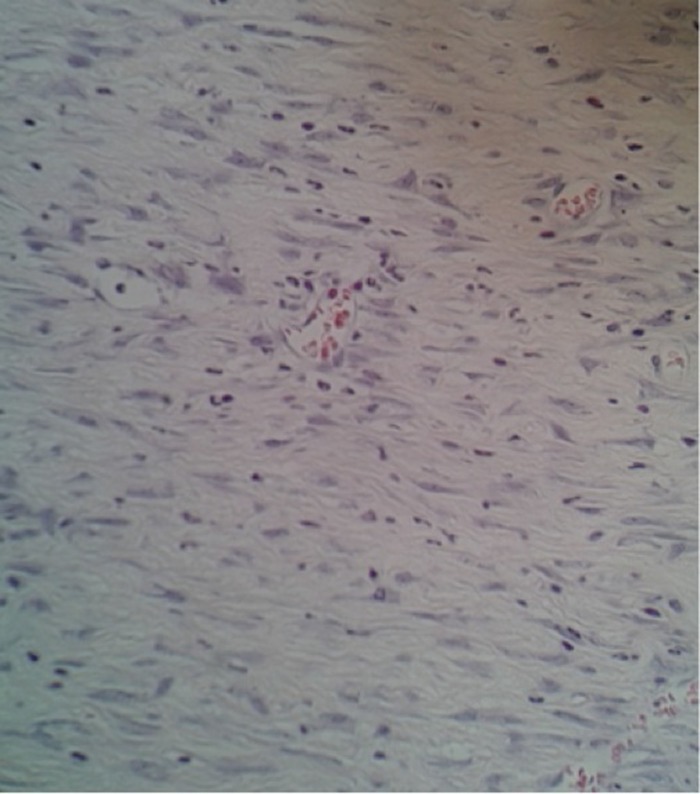
Hematoxylin eosin staining for control group/14 day subset.